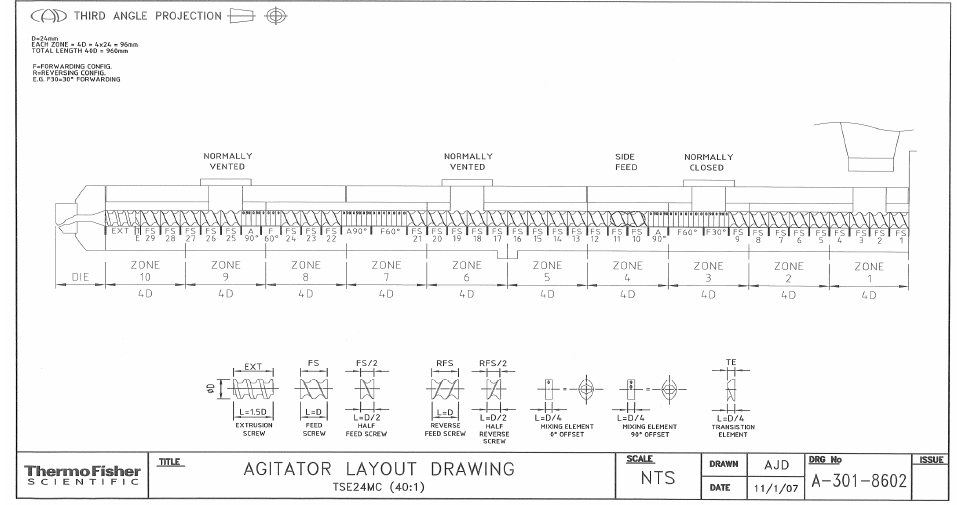
Figure 1. Configuration for the extrusion process.